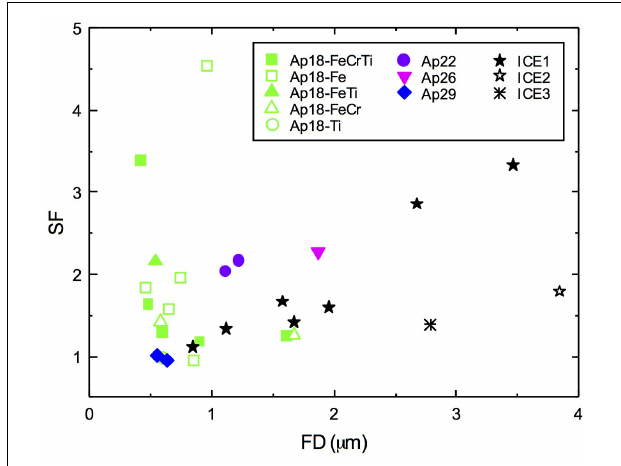
FIGURE 10 | Plot of the Feret diameter (FD) vs. the shape factor (SF) of aerosol and sediment samples.